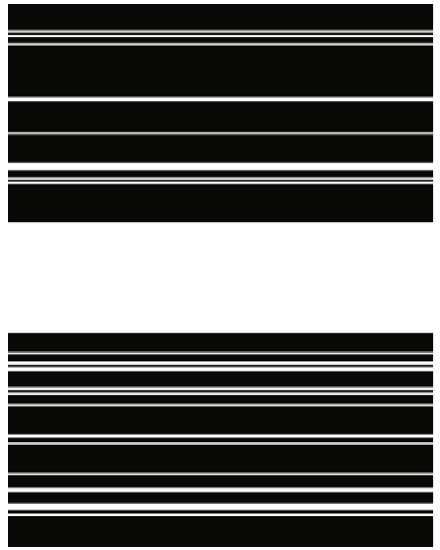
Figure 3: The sampling pattern.